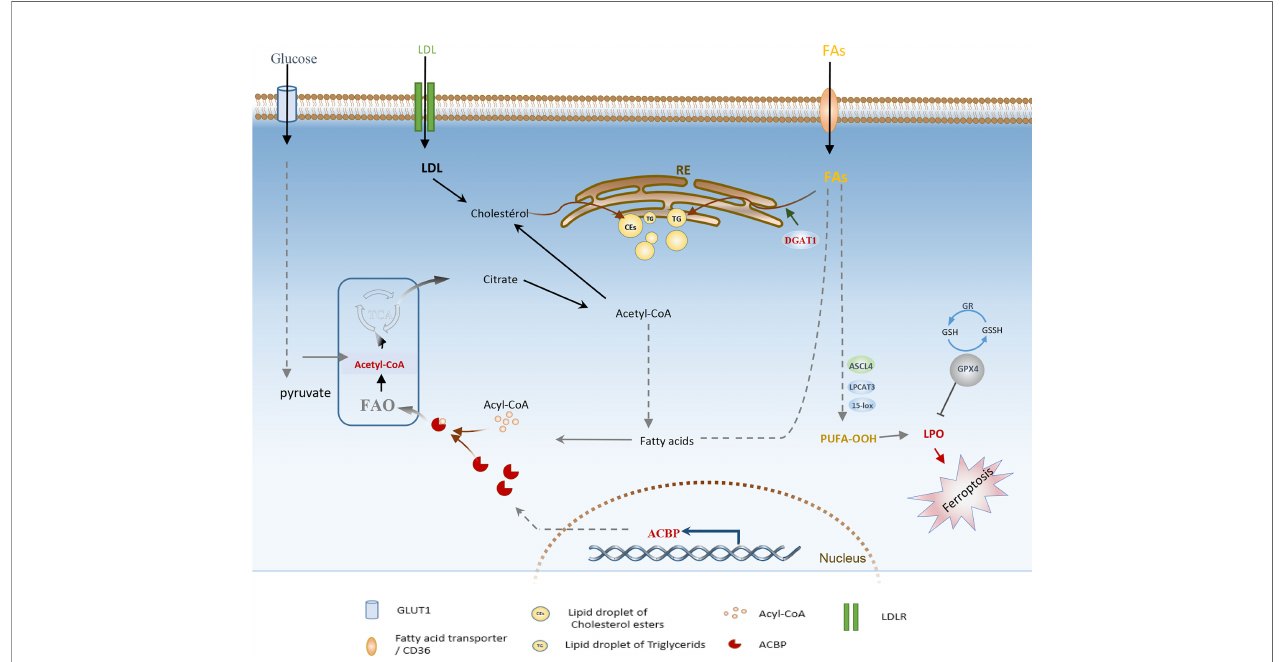
FIGURE 4 | Schematic illustration of adaptive lipid metabolism in glioblastoma: role of the highly expressed ACBP, DGAT1, GPx4, and lipid droplets in lipid oxidation and ferroptosis induction. FAs, Fatty acids; FAO, Fatty acid oxidation; PUFA, Polyunsaturated fatty acids; DGAT1, diacylglycerol-acyltransferase 1; ACSL4, acyl-CoA synthetase long-chain family member 4; GPX4, glutathione peroxidase; GR, glutathione reductase; LD, lipid Droplet; LPO, lipid peroxides; ACBP, Acyl-CoA-binding protein; LDLR, low-density lipoprotein receptor; ER, Endoplasmic